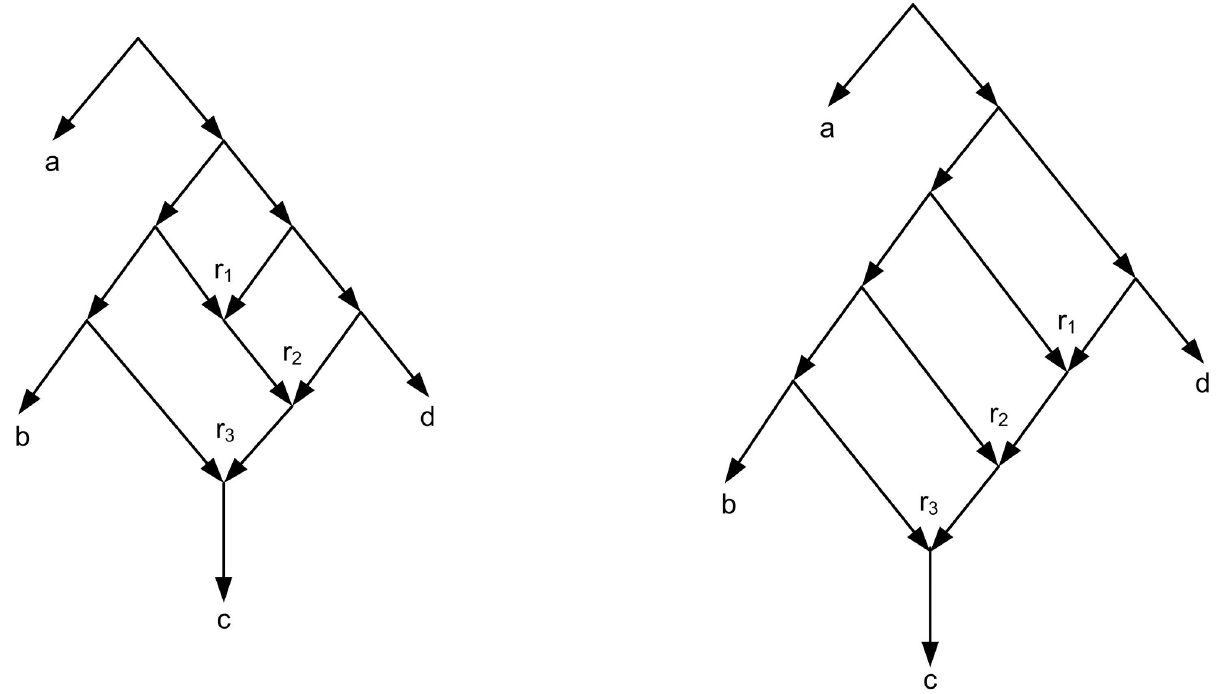
Fig 8. Two different level-3 networks with three reticulation nodes r 1 , r 2 , r 3 .